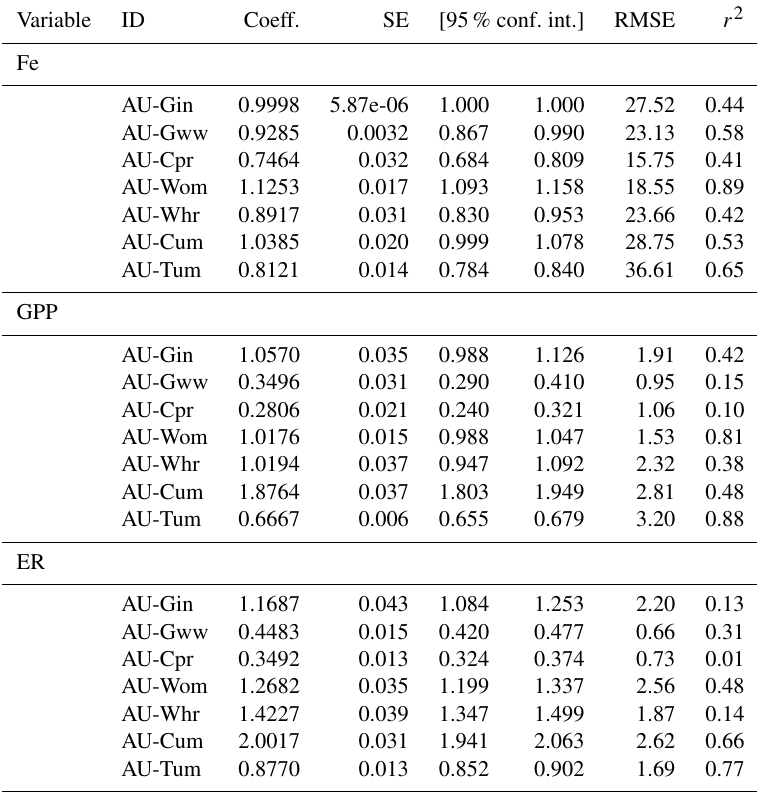
Table A1. Parameters of robust linear model fit between observations and BIOS2 output for all sites, the variables latent heat flux (Fe),